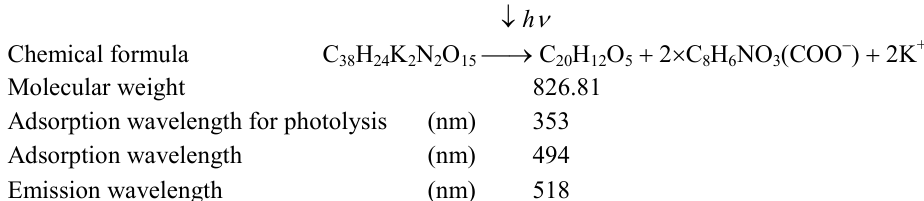
Table 1. Properties of CMNB-caged fluorescein